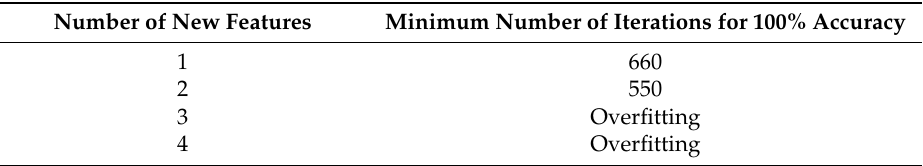
Table 12. Test result of new features with 50